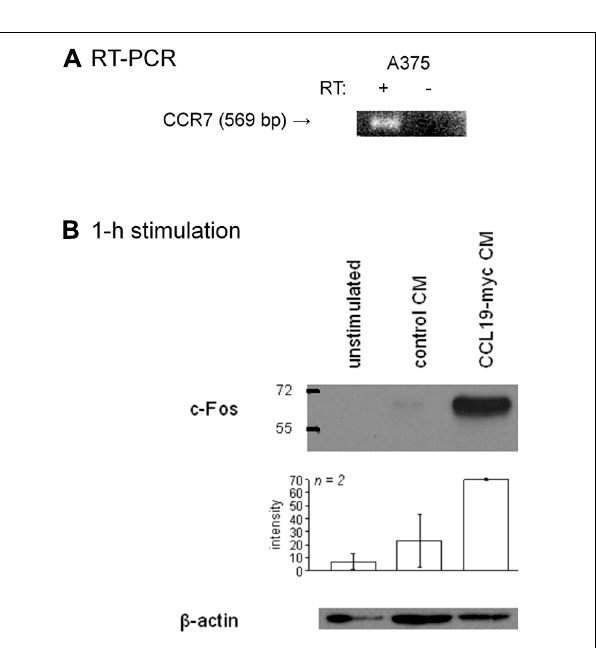
FIGURE 8 | Presence of CCR7 inA375 melanoma cells. (A) RT-PCR for CCR7 in the human melanoma A375 cell line. (B) c-Fos induction in A375 cells stimulated as indicated for 1 h (typical immunoblot and histograms representing the densitometry of replicated experiments).